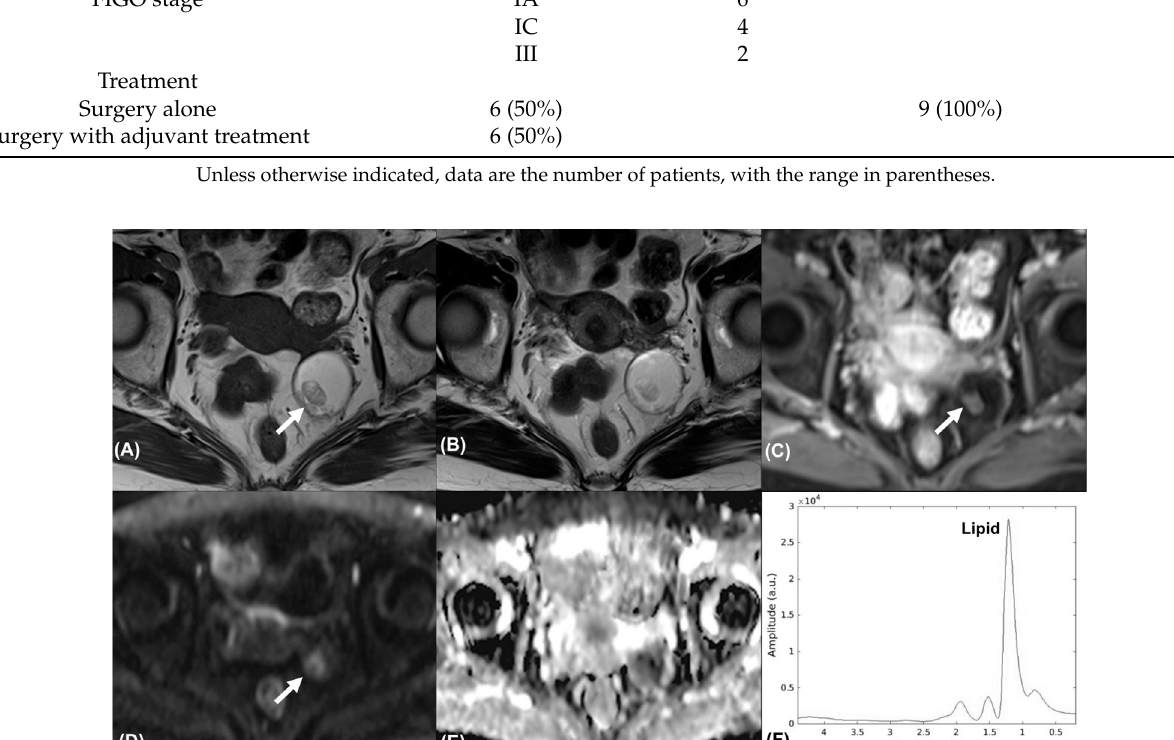
Table 1. Demographics of the study participants.